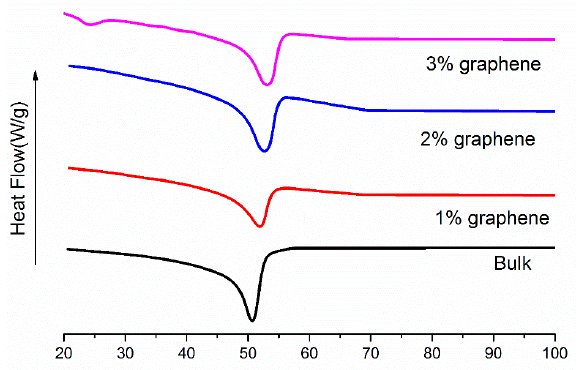
Figure 6. DSC curves of the graphene/H-EP composites.